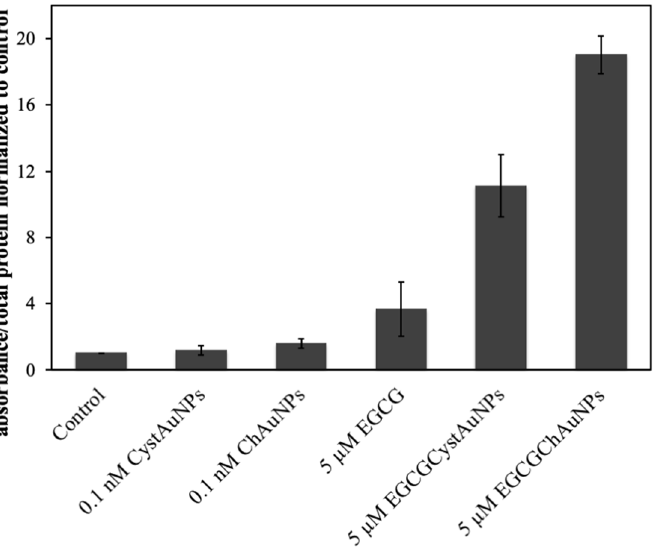
Figure 8. Activation of caspase-3 in BxPC3 cells exposed for 24 h to free EGCG, EGCG-CystAuNPs, EGCG-ChAuNPs, CystAuNPs and